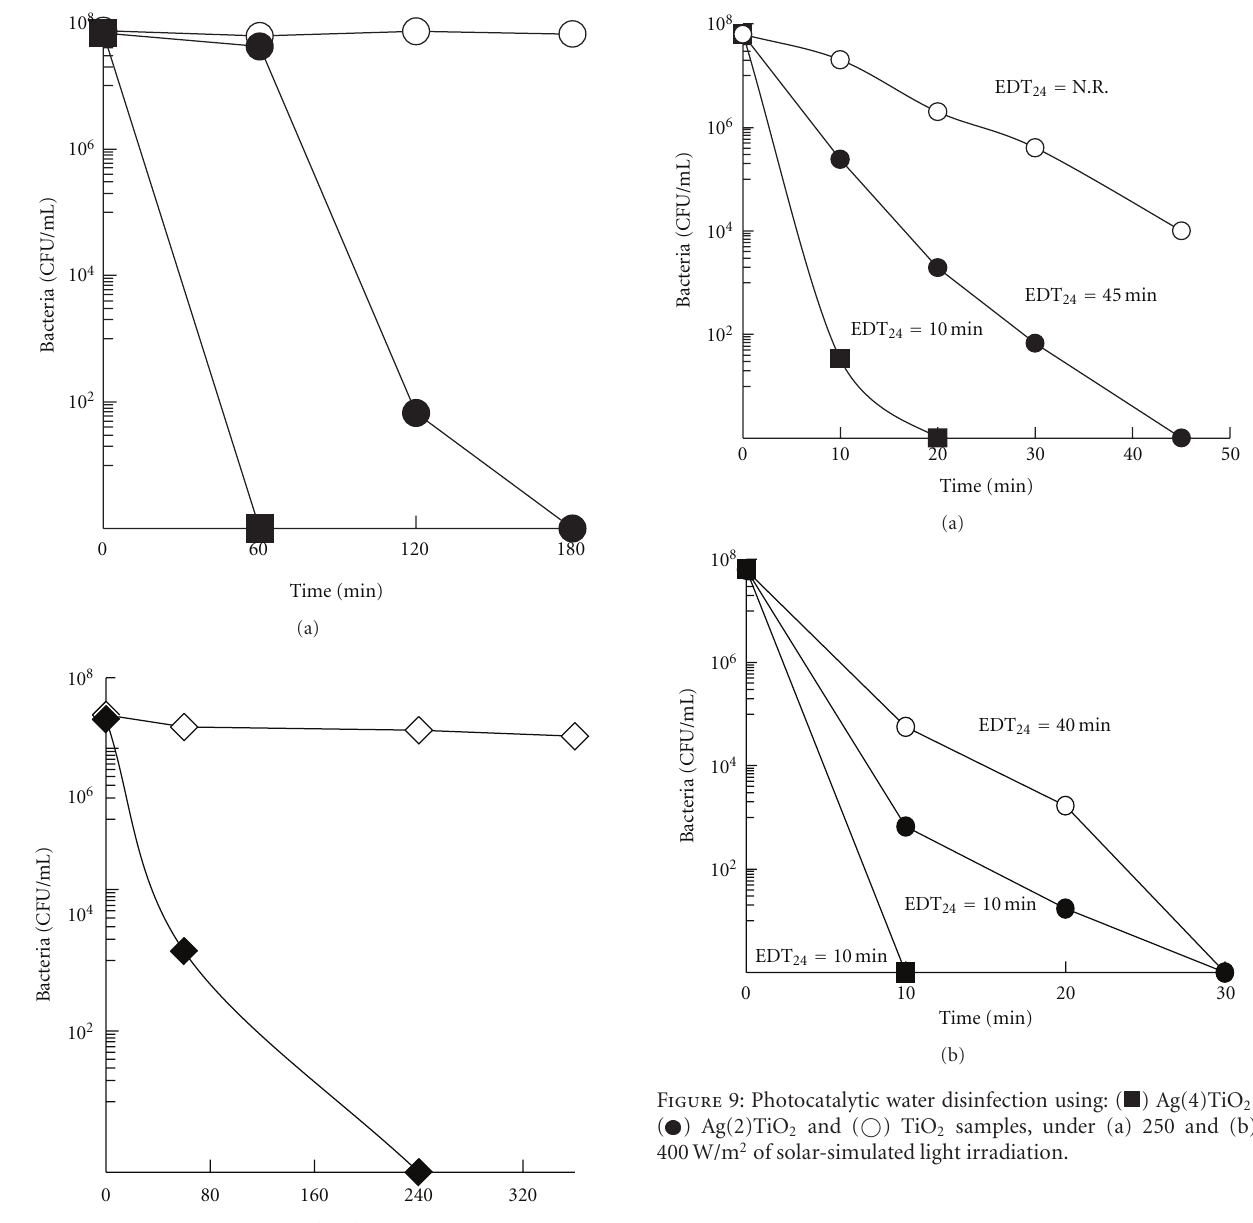
) Ag(4)TiO 2 , ( ) (cid:0) (cid:3) ) Ag(2)TiO 2 , and ( ) TiO 2 . (cid:2) (cid:0)